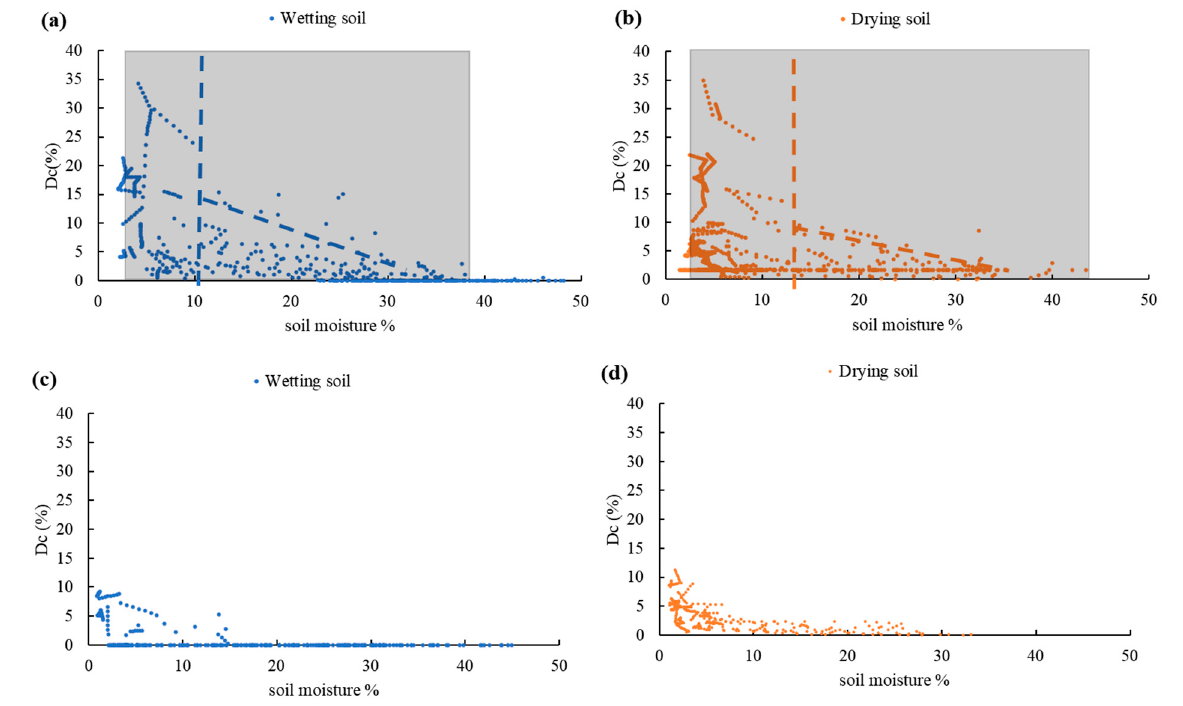
Figure 13. Crack area density: ( a ) for wetting soil—CL; ( b ) for drying soil—CL; ( c ) for wetting soil—SCL; and ( d ) for drying soil—SCL.